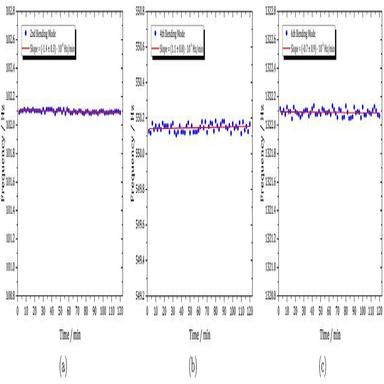
Metglas ribbons stability graphs versus time for the (a) 2nd, (b) 4th and (c) 6th bending modes of the cantilever beam.